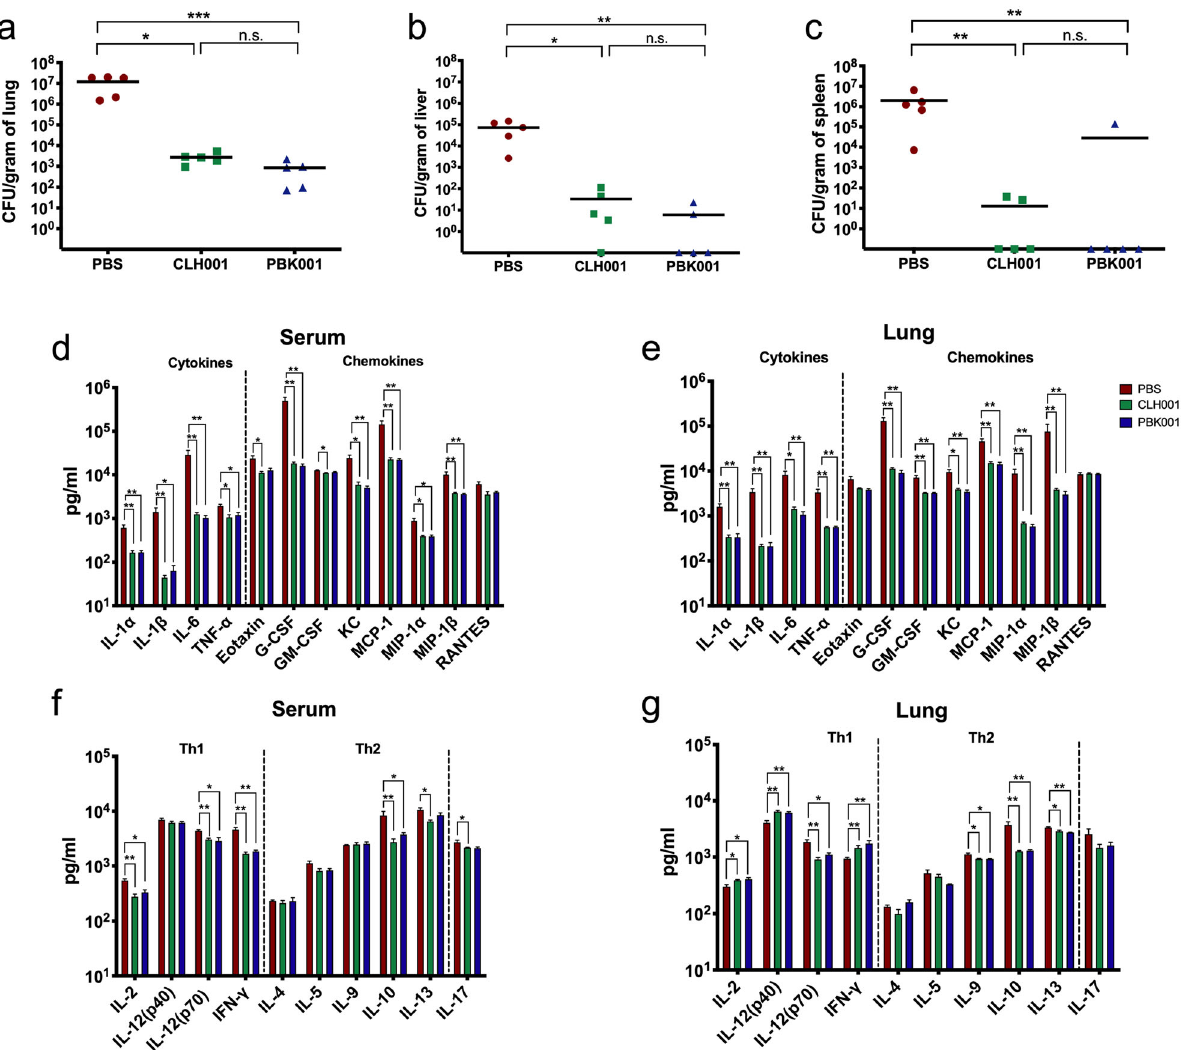
Fig. 6 Intranasal immunization with CLH001 and PBK001 promotes a Th1 effector cytokine response and reduced bacterial burden upon Bpm infection. Bacterial burden in a lung, b liver, and c spleen of mice infected with Bpm K96243 were determined at 48 h after aerosol challenge. The symbols represent individual animals. The lines indicate the mean CFU/g of organ from each group. The proin fl ammatory cytokine/chemokine and Th1/Th2 effectors pro fi les in d , f serum and e , g lung of mice receiving PBS, CLH001, and PBK001 following 48 h exposure to Bpm K96243 via aerosol were measured using ELISA. Mean ± SEM plotted are representative of 5 animals. The signi fi cantly different values between non-vaccinated (PBS) and vaccinated groups were analyzed using t -test: * p <0.05, ** p < 0.01, *** p < 0.001, n.s. = not signi fi